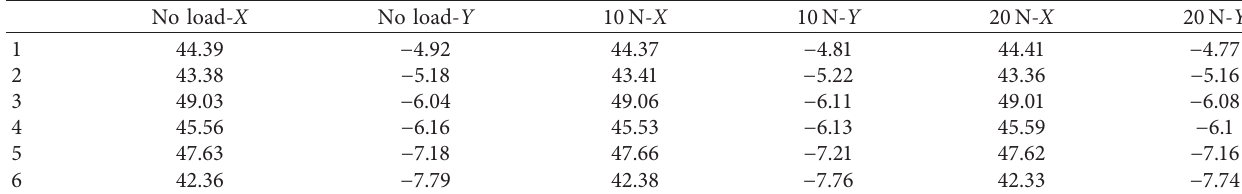
Figure 2: The coordinate statistics of the bridge pier measurement points. Table 3: Cable deformation coordinate statistics.